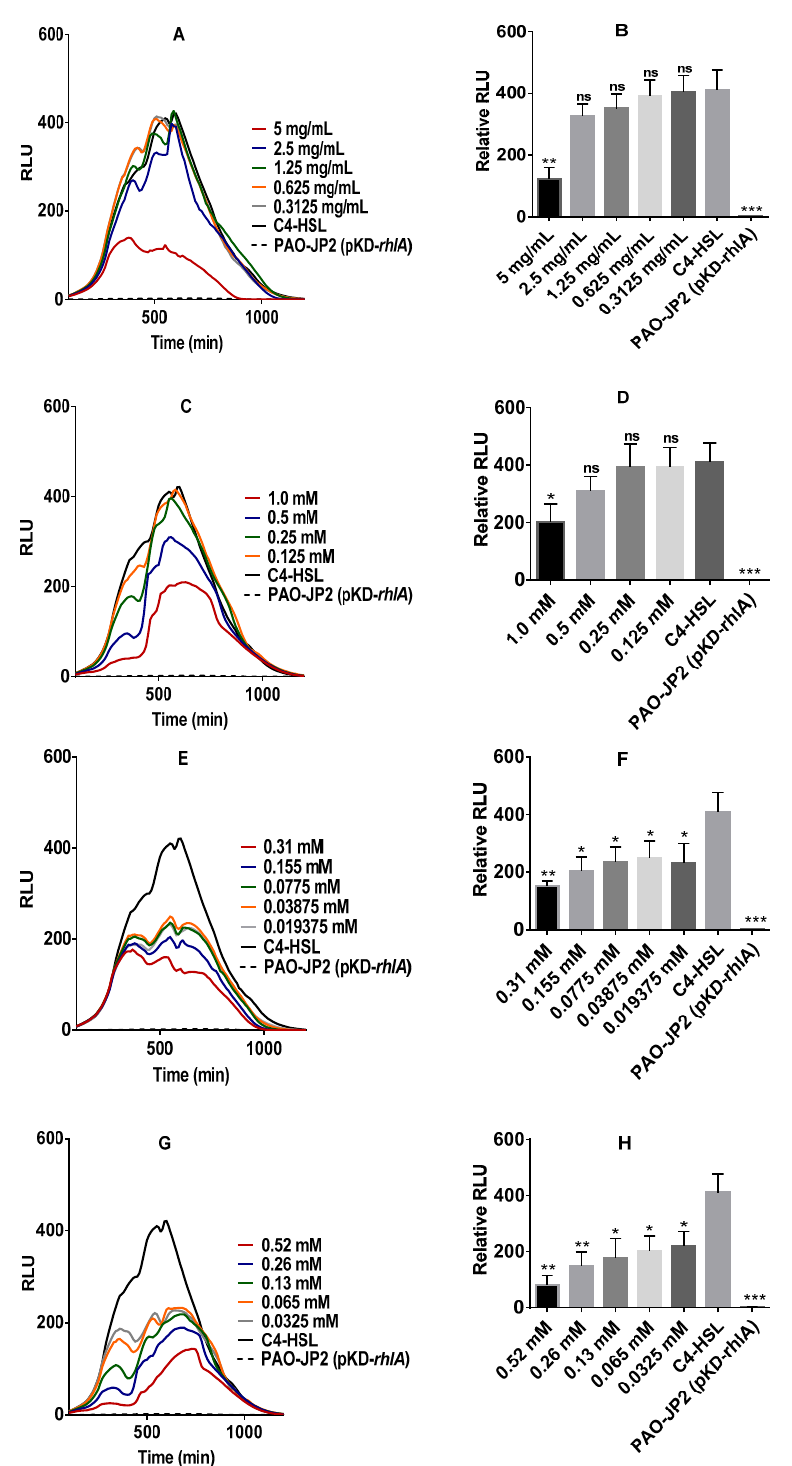
Figure 4. Inhibition of bioluminescence emission of PAO-JP2 (pKD- rhlA ) by pure stevia-derived components. ( A ) stevia extract; ( B ) stevia extract relative to the control, correlating to the data in panel A; ( C ) stevioside, ( D ) stevioside relative to the control, correlating to the data in panel C; ( E ) Reb A, ( F ) Reb A relative to the control, correlating to the data in panel E; ( G ) steviol; ( H ) steviol relative to the control, correlating to the data in panel G. Error bars are not shown in A, C, E, and G to ensure clarity of figures. The final concentration of C4-HSL was 10 µM. All presented concentrations are the final concentrations. The amount of luminescence is expressed in relative light units or RLUs. * p < 0.05, ** p < 0.01, *** p < 0.001, and ns not significant. Values represent mean ± SD, n = 3 (three different experimental readings).